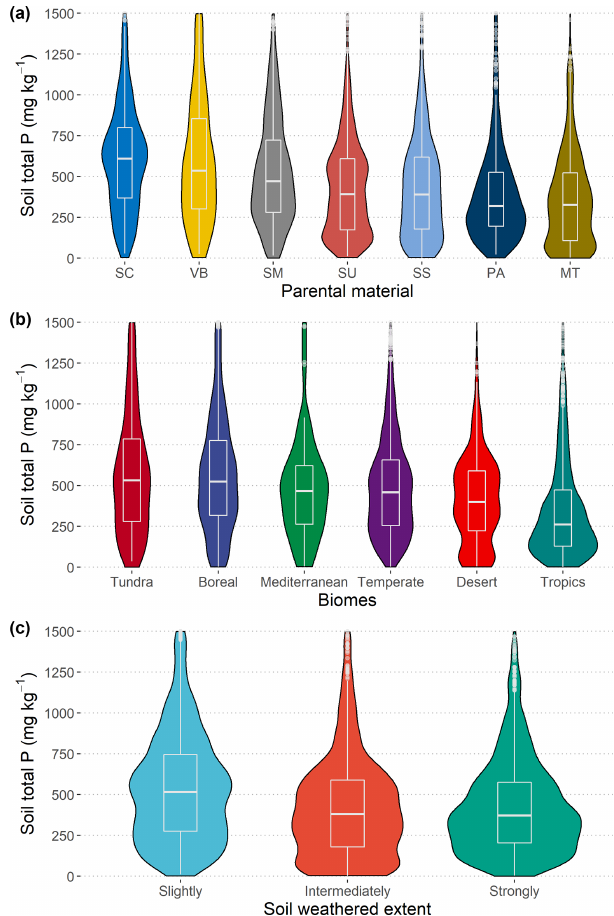
Figure 2. Soil total P concentration in relation to parent material, biome, and soil weathering extent. For visualization, we chose to limit the y axis to 1500mgkg − 1 ; and in panel (a) , only parent ma- terial types with more than 100 measurements in our database were shown; the abbreviations in panel (a) represent the following: SC, carbonate sedimentary; VB, basic volcanic; SM, mixed sedimen- tary; SU, unconsolidated sediments; SS, siliciclastic sedimentary; PA, acid plutonic; MT,